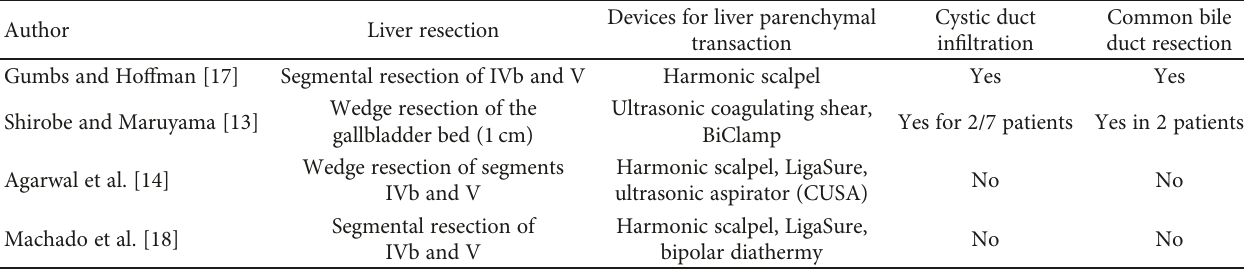
Table 5: IGBC surgery